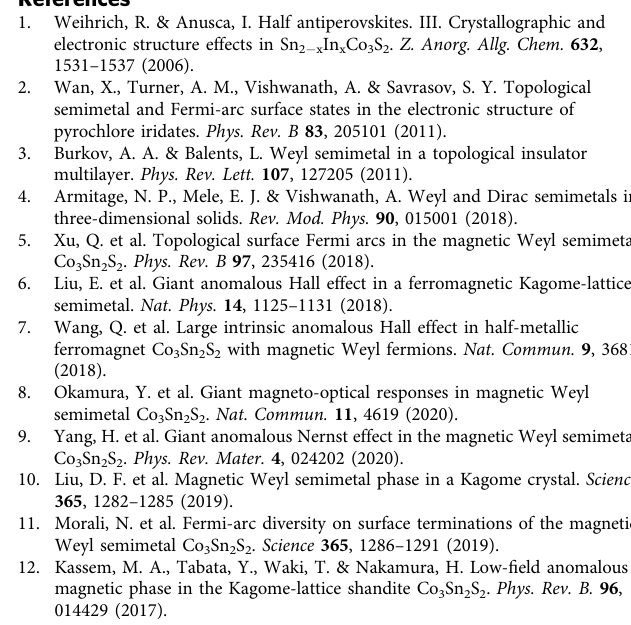
Table 1 Summary of various magnetic constants in uniaxial ferromagnets. Compound